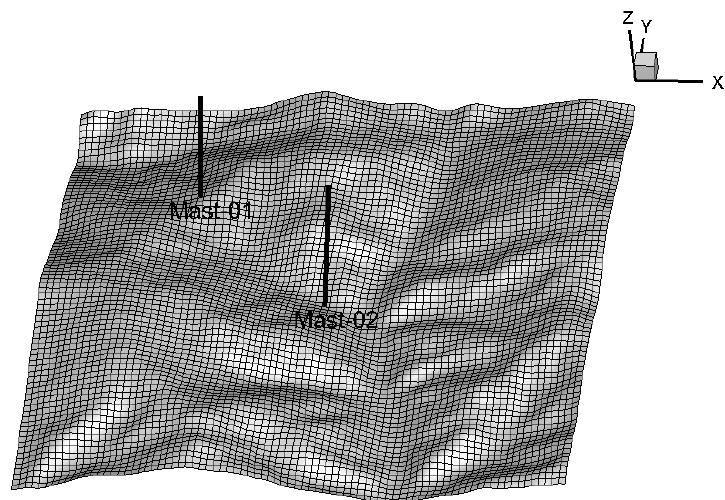
Figure 5. The sites of Mast-01 (coordinates x = 1000, y = 3000) and Mast-02 (coordinates x = 2000, y = 2000) in the CFD domain.